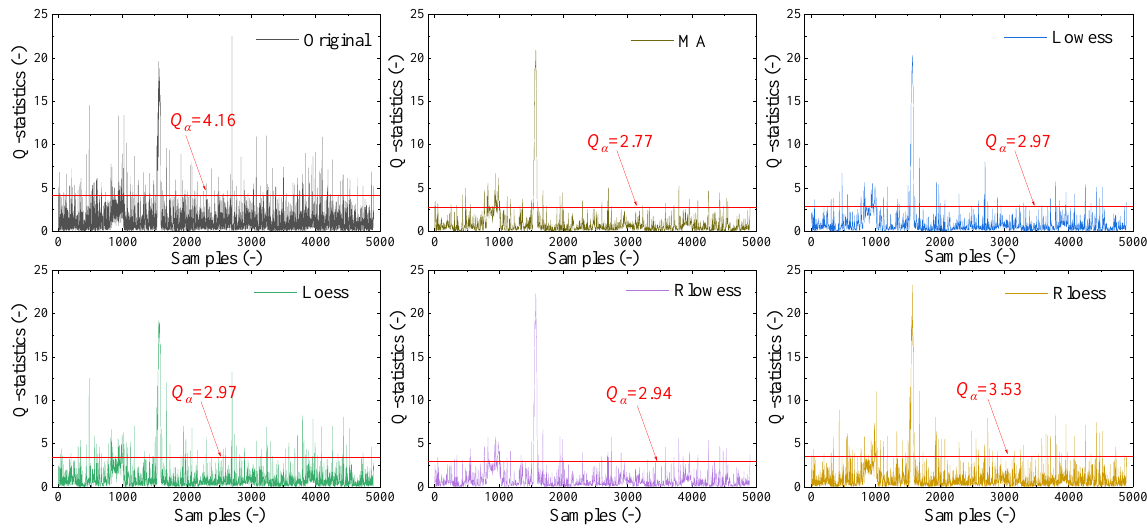
Figure 6. Q-statistics results of training data set for different data optimization methods. Figure 6. Q -statistics results of training data set for different data optimization